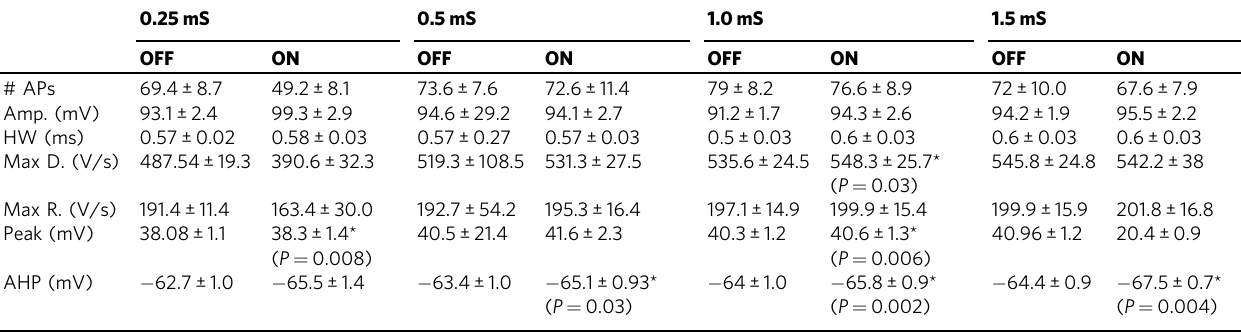
Table 3 Average AP properties from adult male dynamic clamp experiments.